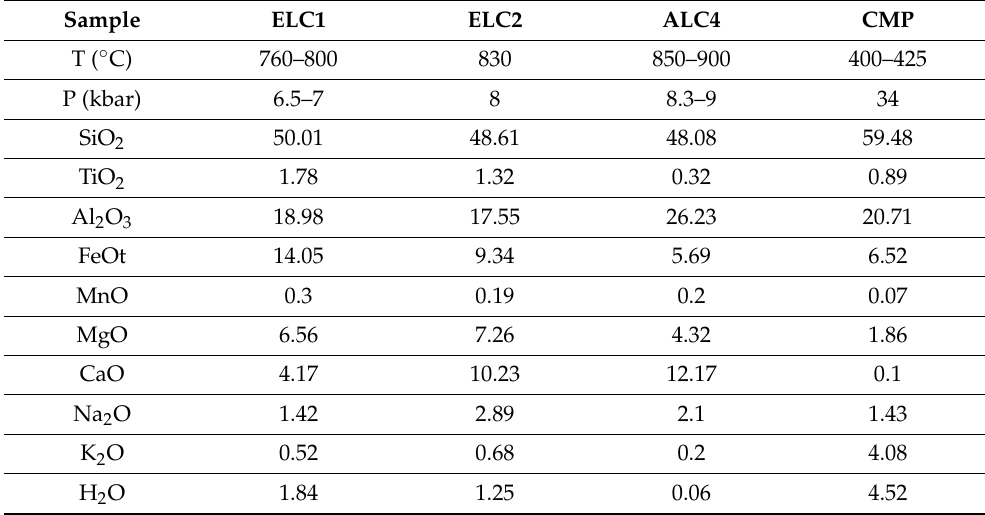
Table 5. Major elements composition and equilibrium P-T conditions of Perple_X